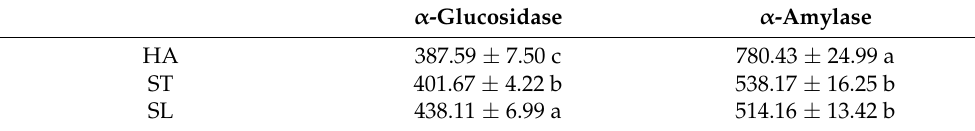
Table 5. Inhibitory effect of different fixing methods on ODT enzyme activity (IC 50 µ g/mL).